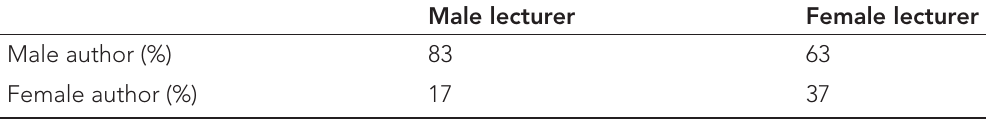
Table 5: Who assigns which authors? (Source: Authors, 2021)